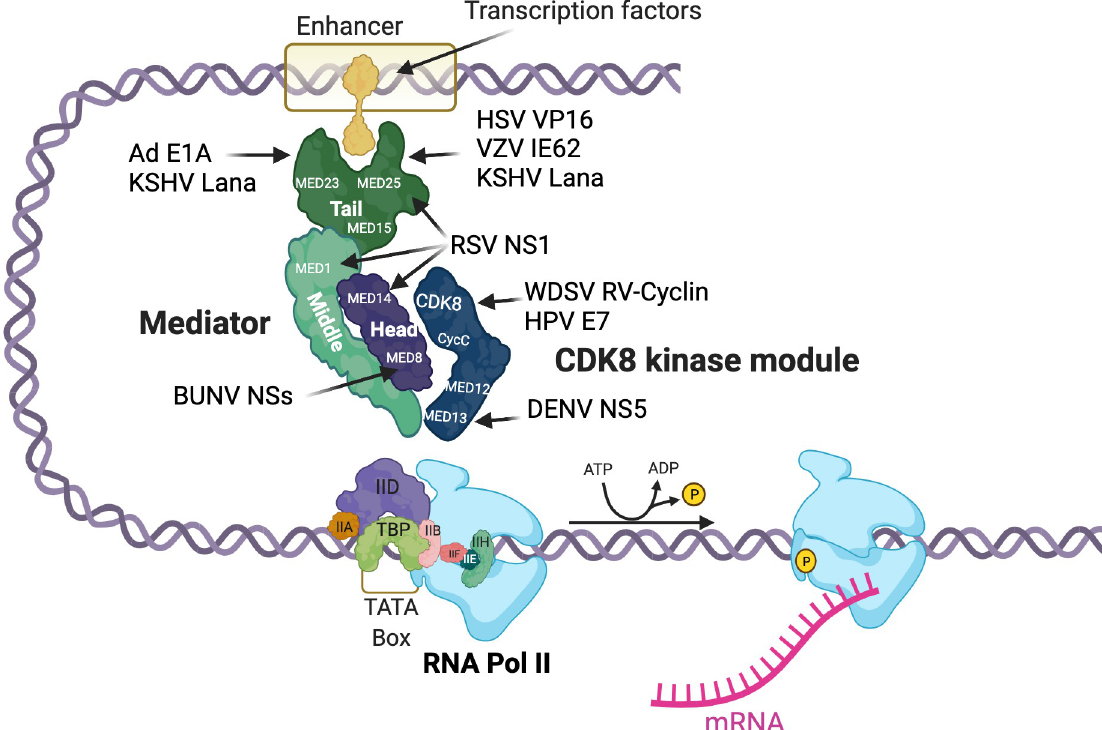
Fig 1. Viral proteins target the Mediator complex to control viral and host gene expression. Viral proteins known to bind to or associate with Mediator proteins in the tail, middle, and head and CDK modules are depicted. A AU : TheabbreviationlistofFig 1 hasbeenmodified : Pleaseverifythatallentriesarecorrect : d, adenovirus E1A; BUNV, Bunyamwera virus NSs; CDK8, cyclin-dependent kinase 8; DENV, dengue virus NS5; HPV, human papilloma virus E7; HSV, herpes simplex virus VP16; KSHV, Kaposi sarcoma–associated herpesvirus Lana-1; RSV, respiratory syncytial virus NS1; RV-cyclin, retroviral cyclin; VZV, varicella zoster virus IE62; WDSV, Walleye dermal sarcoma virus. Created with BioRender.com.